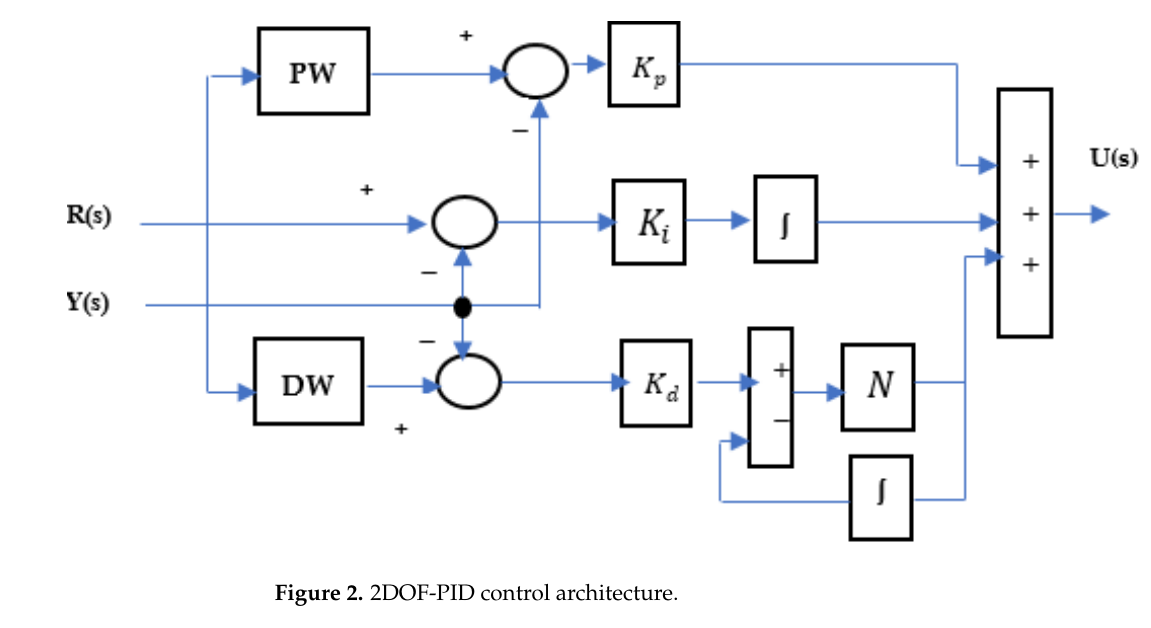
Figure 2. 2DOF-PID control architecture.